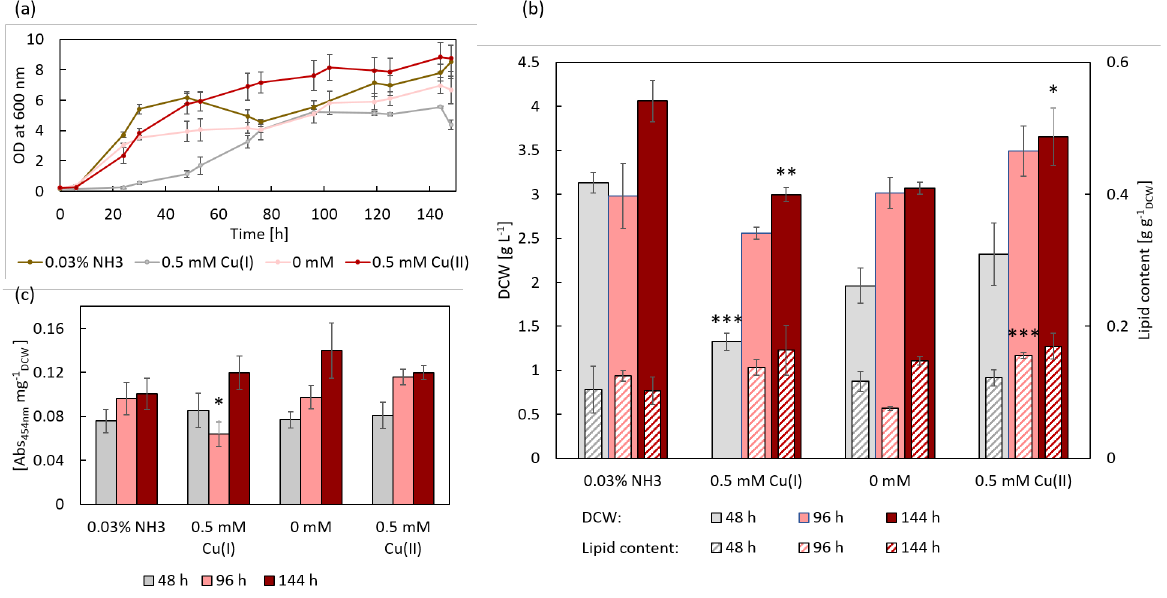
Figure 2. Growth, lipid, and carotenoid accumulation of R. toruloides IFO0559 supplemented with 0.5 mM of Cu(I) and Cu(II), as well as respective control, whereas NH 3 served as control for Cu(I)-treated samples and 0 mM served as control for Cu(II)-treated samples. * p < 0.05, ** p < 0.01, *** p < 0.001 ( t -test always evaluated against respective control), n = 3. ( a ) Growth measured as OD at 600 nm over 144 h. ( b ) Biomass formation (DCW) and lipid content (normalized to DCW) at 48, 96, and 144 h. No lipid content was determined for 0.5 mM Cu(I) at 48 h, as not enough biomass had accu- mulated at this time point. ( c ) Carotenoid accumulation (normalized to DCW) at 48, 96, and 144 h. 3.3. Influence of Cu(I) and Cu(II) on R. toruloides IFO0880 The effect of Cu(I) and Cu(II) on the growth behavior and metabolism of R. toruloides IFO0880 was analyzed (Figure 3). Cultures with 0.5 mM Cu(I) as well as the respective control group contained 0.03% ammonia. The highest OD 600nm was detected for cultures supplemented with 0.03% ammonia, with an OD 600nm of 7.37. The growth of cultures, sup- plemented with 0.5 mM Cu(I), stagnated after inoculation for 53 h in a prolonged lag phase, before growing to a maximum OD 600nm of 5.81. When supplemented with Cu(II), the cells grew faster compared to those without supplements (0 mM) reaching final OD 600nm of 5.49 and 3.00, respectively (Figure 3a). The highest DCW of 3.63 g L −1 was achieved in cultures with 0.03% ammonia after 48 h, while cultures supplemented with 0.5 mM Cu(I) only reached a DCW of 1.37 g L −1 , reconfirming the severe inhibition of growth by Cu(I) (*** p < 0.001). While the DCW of ammonia control samples remained fairly constant over time, the DCW of Cu(I) treated samples steadily increased to a final weight of 3.05 g L −1 . In contrast, Cu(II) treatment increased biomass formation to 2.65 g L −1 after 96 h and 2.33 g L −1 after 144 h, while the control group without supplementation reached 1.70 g L −1 and 1.49 g L −1 , respectively (Figure 3b). When grown in YNB medium without any additives (0 mM), IFO0880 exhibits a lipid content of 4.6% after 96 h. Lipid content significantly increased with the addition of 0.5 mM Cu(II) to 13.5%. When treated with Cu(I), the lipid content was 8.4%, while control cultures, supplemented solely with 0.03% ammonia accumulated 25.3%. After another two days (144 h), the lipid content in the control group (0 mM) increased to 5.2%, while cultures treated with 0.5 mM Cu(II) decreased to 9.7%. Cultures treated with 0.5 mM Cu(I) exhibited a lower lipid content (12.5%) than the control group treated with ammonia (19.3%) (Figure 3b). Accordingly, significant changes in overall lipid accumulation can be noted in samples treated with ammonia, which exhibit strongly increased lipid levels,